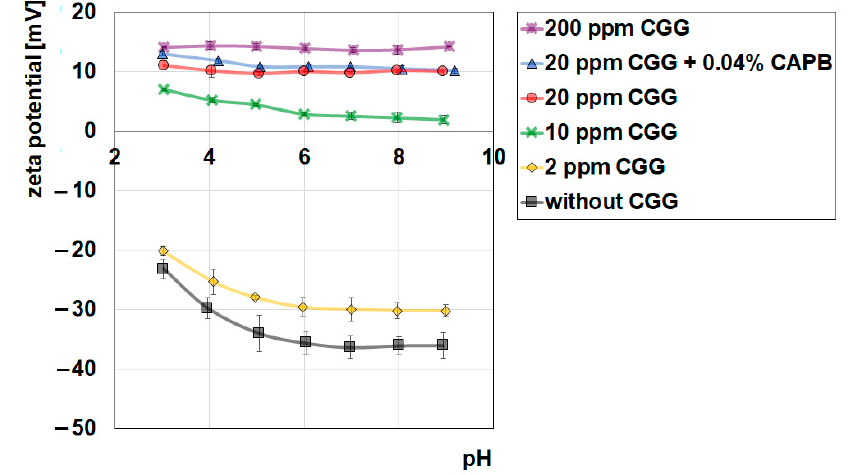
Figure 8. Influence of CGG and CAPB (0.04%) on the zeta potential of glauconite.